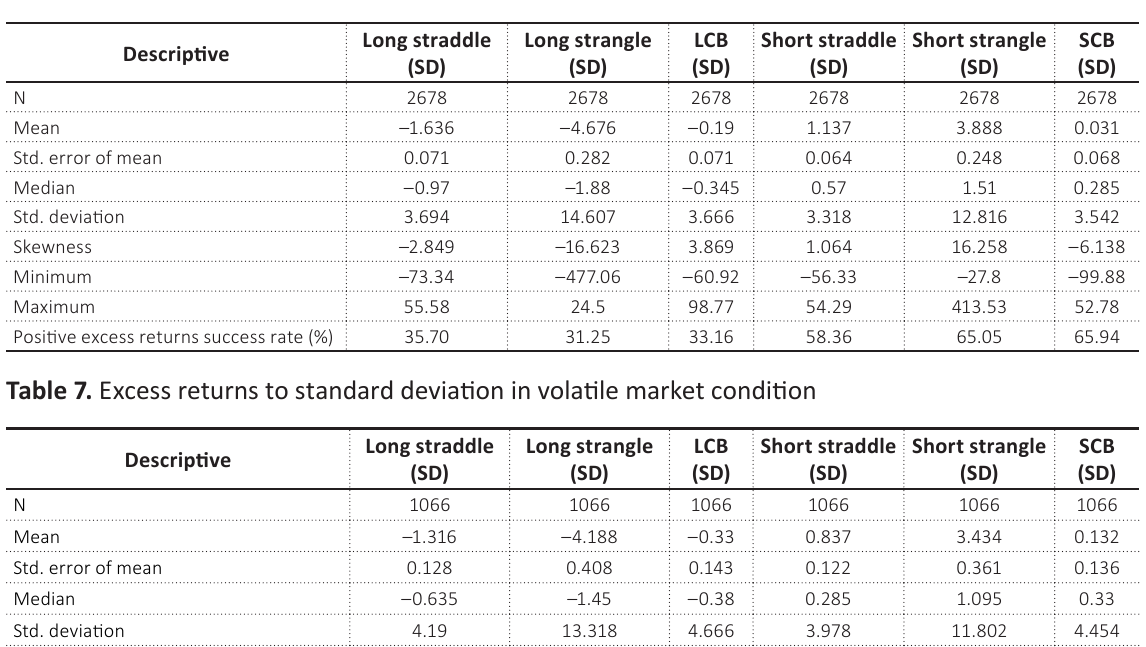
Table 6. Excess returns to standard deviation in neutral market condition